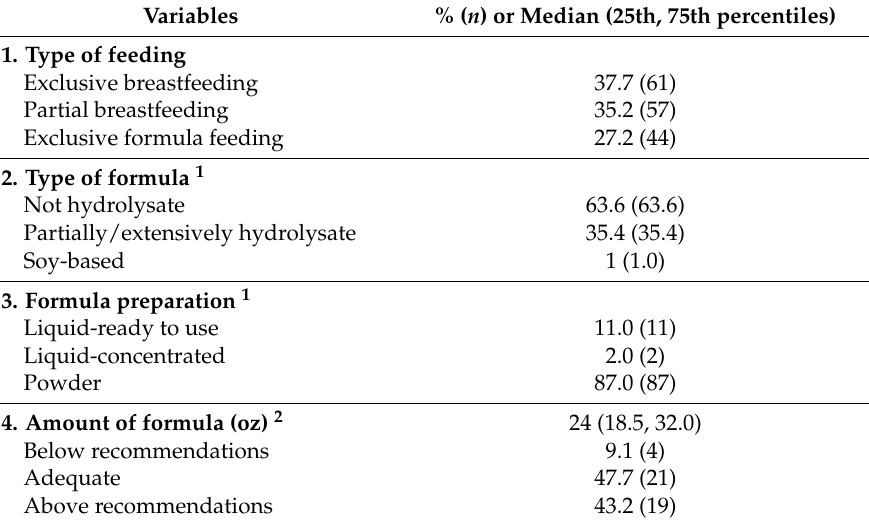
Table 2. Feeding patterns at baseline ( N =